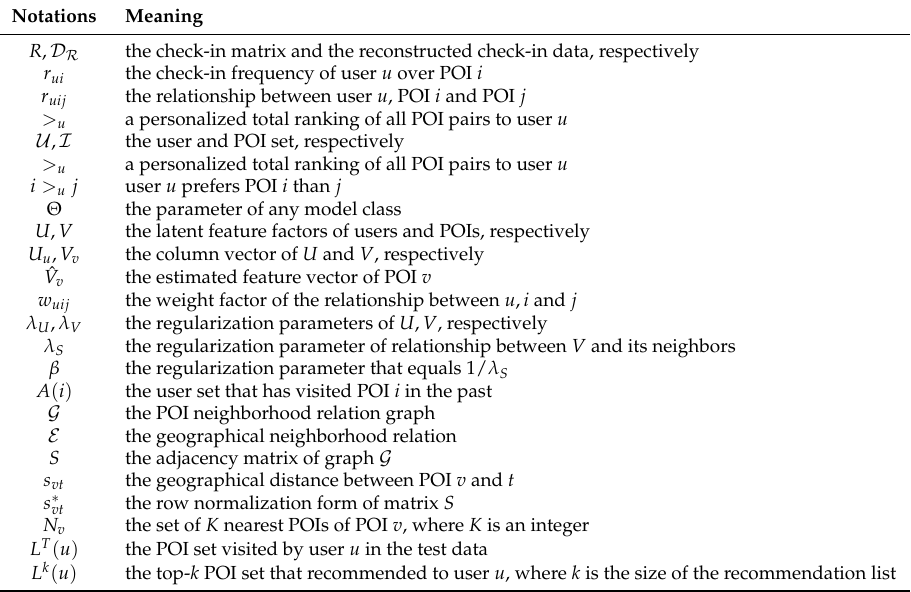
Table 1. Table of notations of this